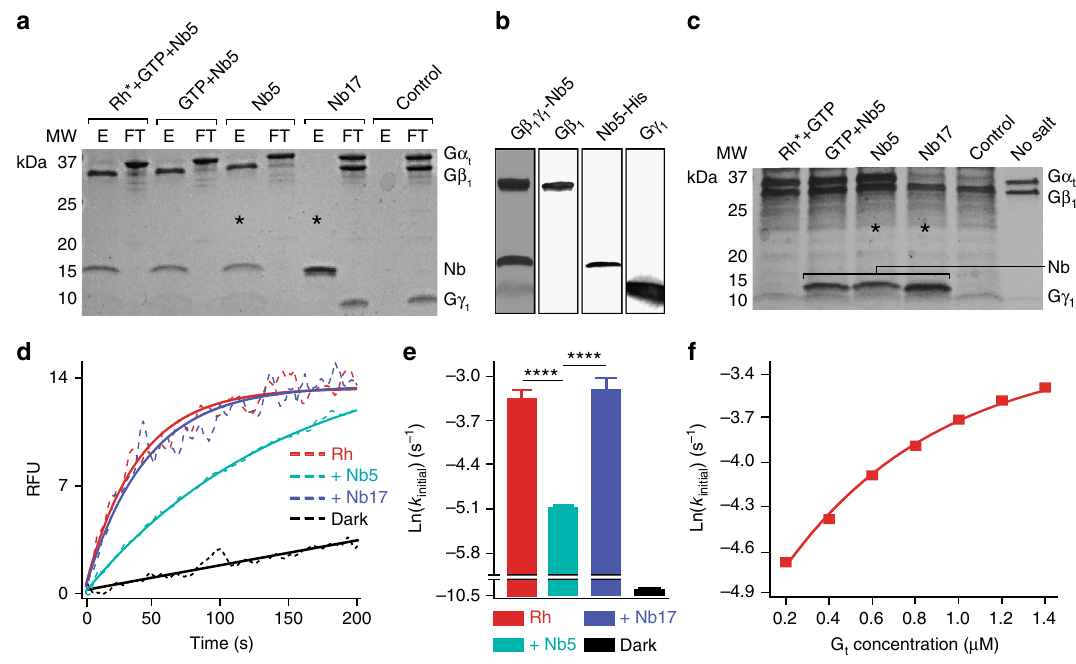
Fig. 1 Nanobody-mediated shift in heterotrimeric G t equilibrium. a Effect of Nb5 on the heterotrimeric state of G t in solution. Lane 1 shows the dissociation of heterotrimeric G t in the presence of light-activated Rh (Rh*), GTP, and Nb5. G β 1 γ 1 was later co-puri fi ed with Nb5 by immobilized-Ni 2 + af fi nity chromatography and G α t emerged as an unbound protein in the fl ow-through (lane 2). Note the decrease in G γ 1 Coomassie staining in the presence of 300 mM imidazole during protein elution. Similar results were obtained from the reaction mixture in the absence of either Rh* alone (lanes 3 and 4) or both Rh* and GTP (lanes 5 and 6). However, Nb17 did not affect the heterotrimeric con fi guration of G t (lanes 7 and 8, compare lanes marked with asterisks). Additionally, non-speci fi c interactions between G β 1 γ 1 and Ni 2 + -NTA resin were not seen (lanes 9 and 10). The eluate and fl ow-through obtained from af fi nity chromatography puri fi cation are denoted as E and FT, respectively. b Proteins in typical eluates obtained after immobilized-Ni 2 + af fi nity chromatography were analyzed by SDS-PAGE (lane 1) and immunoblotting with antibodies speci fi c to G β 1 , His-tag, and G γ 1 , respectively (lanes 2 – 4). c Light activation of ROS membranes in the presence of GTP released G α t in the high salt wash (lane 1). Similar G α t release was obtained with Nb5 with or without GTP during the high salt wash (lanes 2 and 3). Treatment of ROS membranes with Nb17 had no effect on G α t release (lane 4, compare lanes marked with asterisks). Untreated ROS membranes showed no G α t release during the high salt wash (lane 5). d The initial G t activation rate of Rh* was reduced upon pre-treatment of heterotrimeric G t with Nb5 (greencyan) as compared to either untreated (red) or Nb17-treated G t (purple). e Quanti fi cation of the initial G t activation rates of Rh* with and without nanobody pre-treatment. Results are expressed as the mean ± SD, n = 3 replicates, **** P < 0.0001, Student ’ s t -test. f The decrease in G t activation rates after Nb5 treatment were explained by Rh single turnover experiments that exhibited an